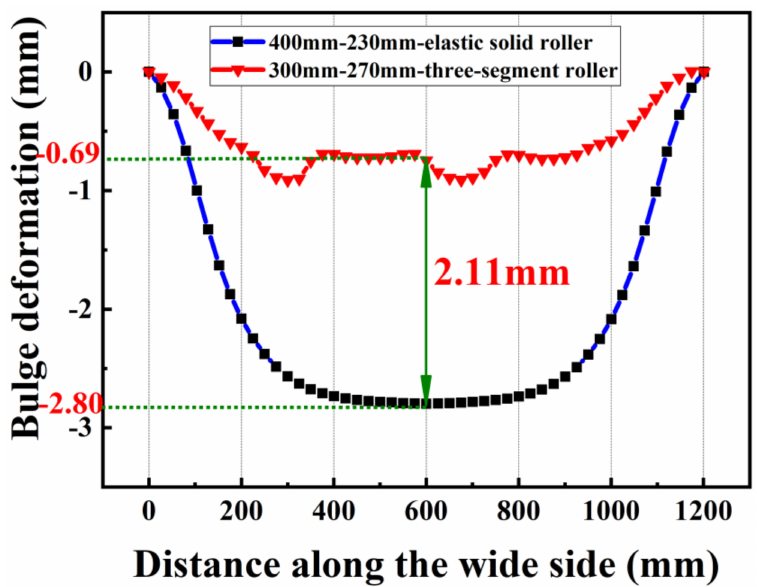
Figure 11. Comparisons of slab bulge deformation with different segment roller structure